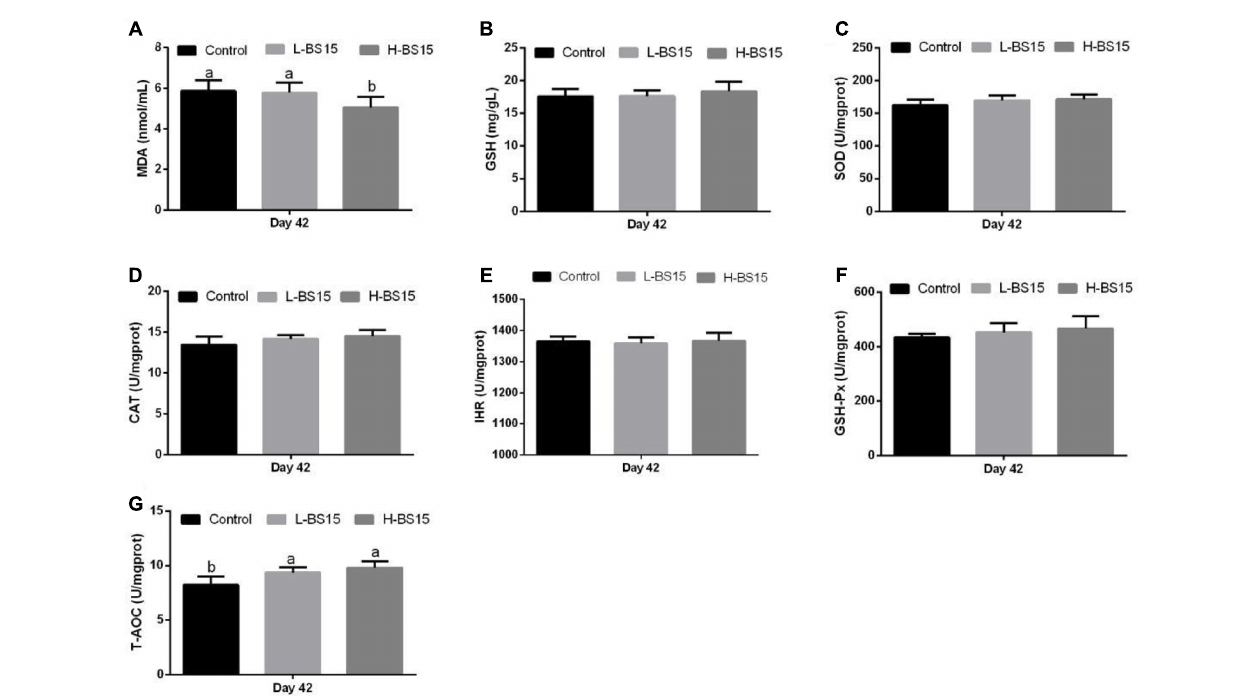
FIGURE 2 | Changes of MDA (A) , GSH (B) , SOD (C) , CAT (D) , IHR (E) , GSH-Px (F) , and T-AOC (G) in the serum at days 42 in Experiment 1. Bars with different letters are significantly different on the basis of Duncan’s multiple range tests ( P < 0.05). Data are presented as mean ± standard deviation (six replicates of one chick per cage). T-AOC, total antioxidation capacity; CAT, catalase; SOD, superoxide dismutase; GSH-Px, glutathione peroxidase; IHR, inhibiting hydroxy radical; MDA, malondialdehyde; GSH,